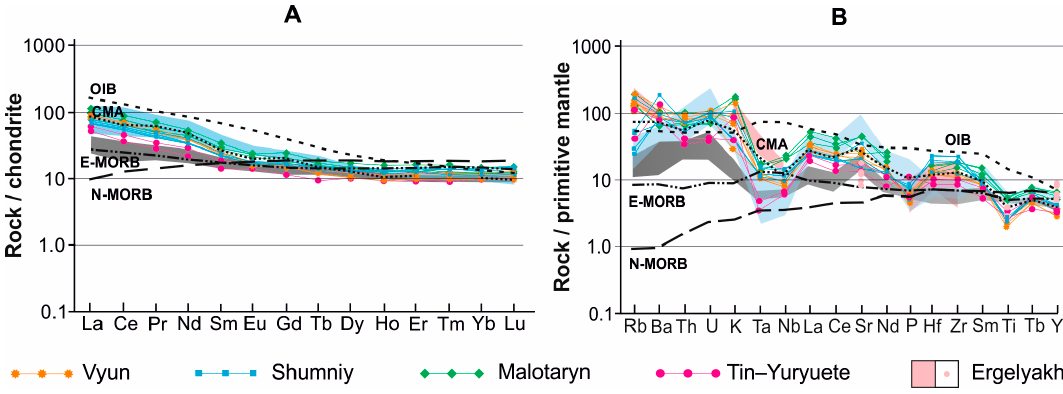
Figure 6. REE diagram ( A ) and spider diagram ( B ) for the studied igneous rocks. Chondrite and primitive mantle normalizing values were from [62]. Blue and grey fields—concentrations for Grenada Island (Lesser Antilles island arc) basalts with, respectively, a peridotite–pyroxenite source (5% mantle wedge melting) and a mainly peridotite source (25% Mg-enriched mantle wedge melting) [63]. Concentrations from the Ergelyakh pluton granite–porphyry and granodiorite–porphyry were from [13].